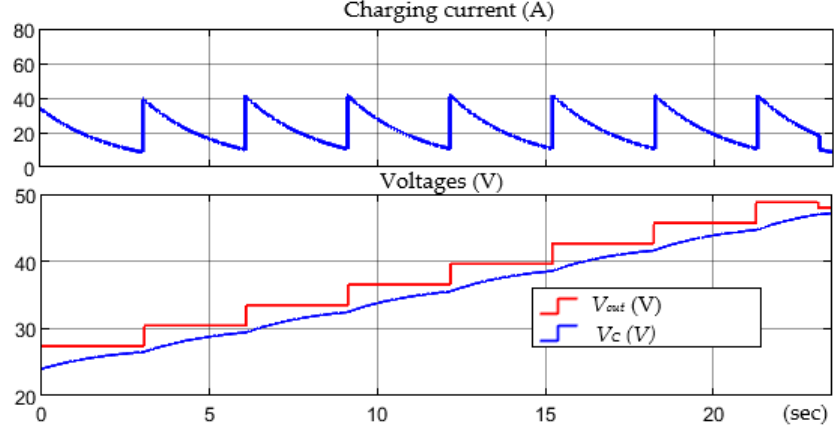
Figure 41. SC charging simulation result diagrams.